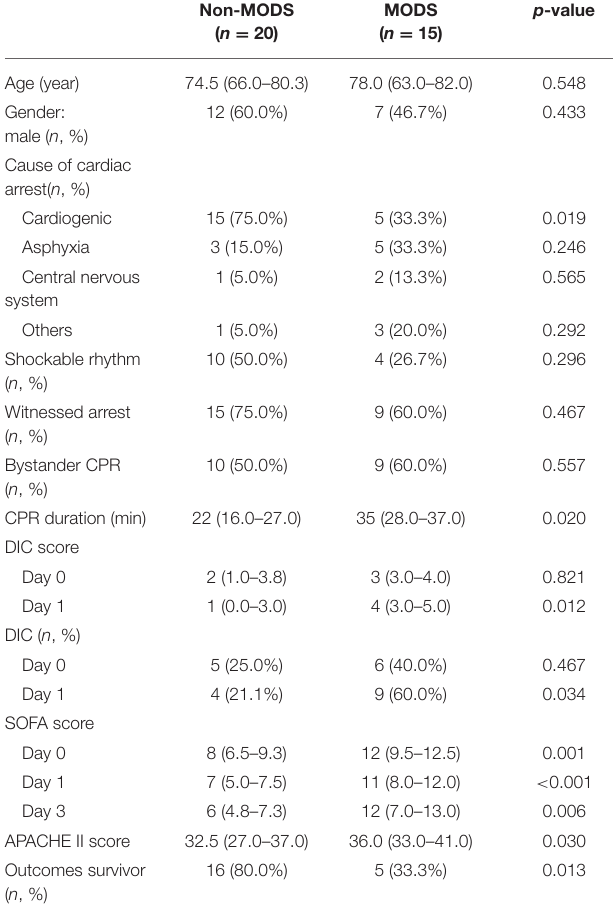
TABLE 1 | Baseline characteristics of patients with PCAS with and without